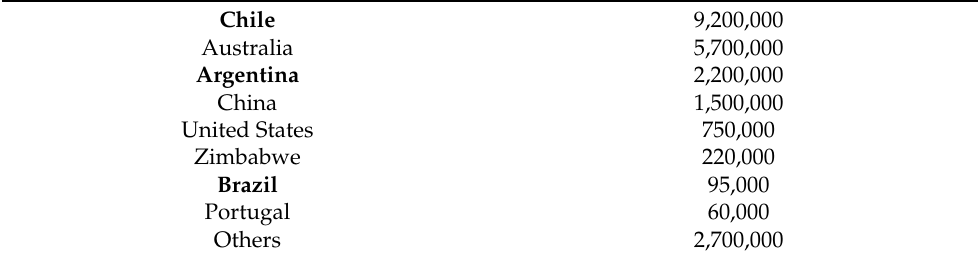
Table 2. Lithium Resources (2021 (tons)) (Total Resources 89.1 million tons). Country Reserves Country Reserves 21 million